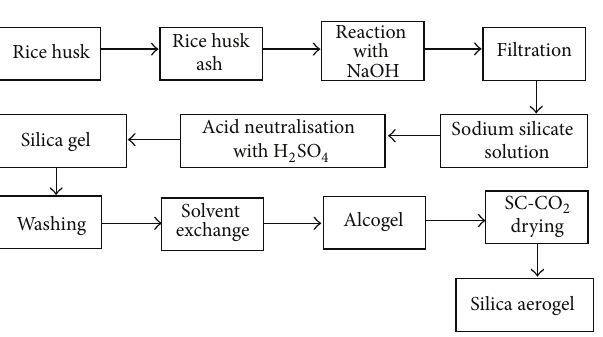
Figure 2: Schematic procedure of Maerogel preparation from rice